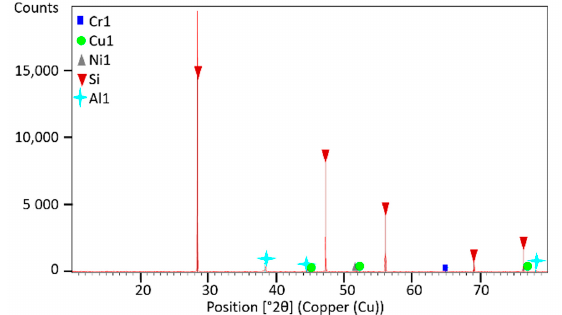
Table 7. Harmful elements in a different fraction of ground WEEE.